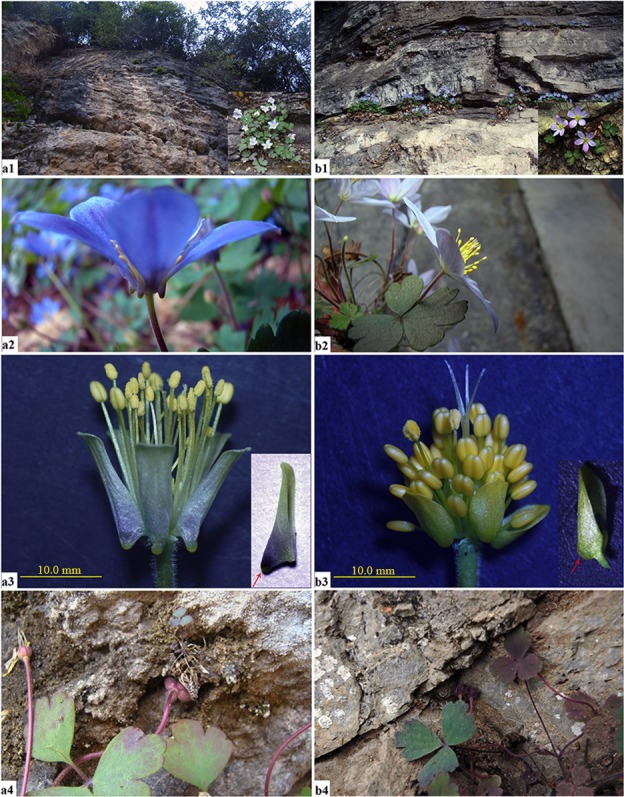
The morphological characters of Urophysa rockii (a1–a4) and Urophysa henryi (b1–b4).1: Habitat feature; 2: Flowers; 3: Anatomical characteristics of petals; 4: Seed dispersal. The red arrows represent spurred petals and saccate petals in a3 and b3, respectively.